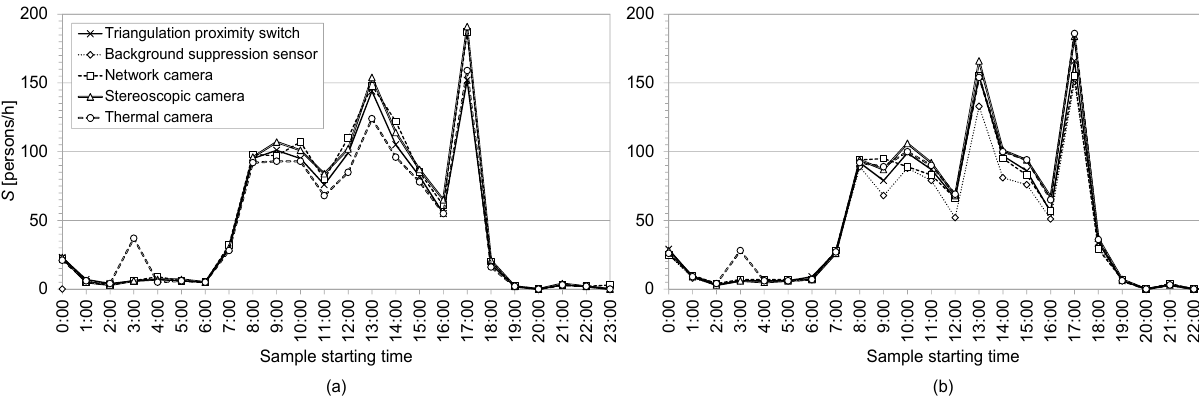
Figure 4. Example of hourly sensor readings S for ( a ) A and ( b ) B directions.